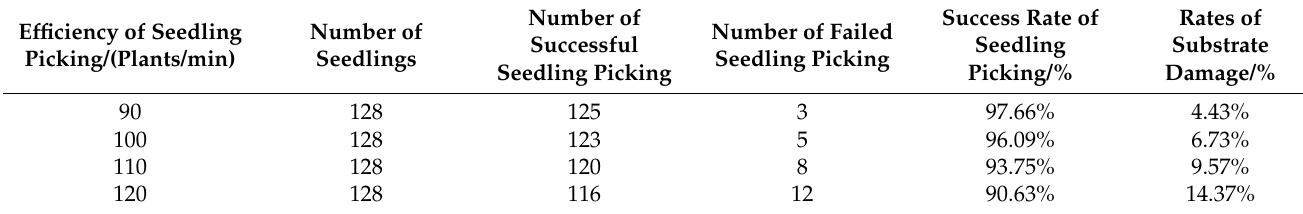
Figure 14. Results of seedling sampling test.